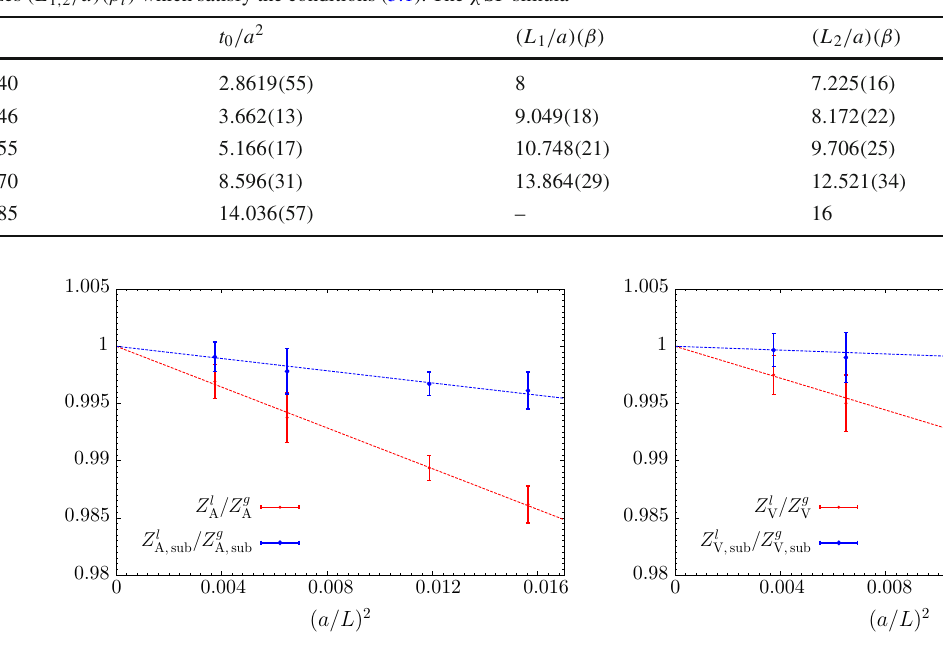
) is also shown. The dashed lines correspond to linear fits to the to O ( g 2 0 data, constrained to extrapolate to 1 for a / L =